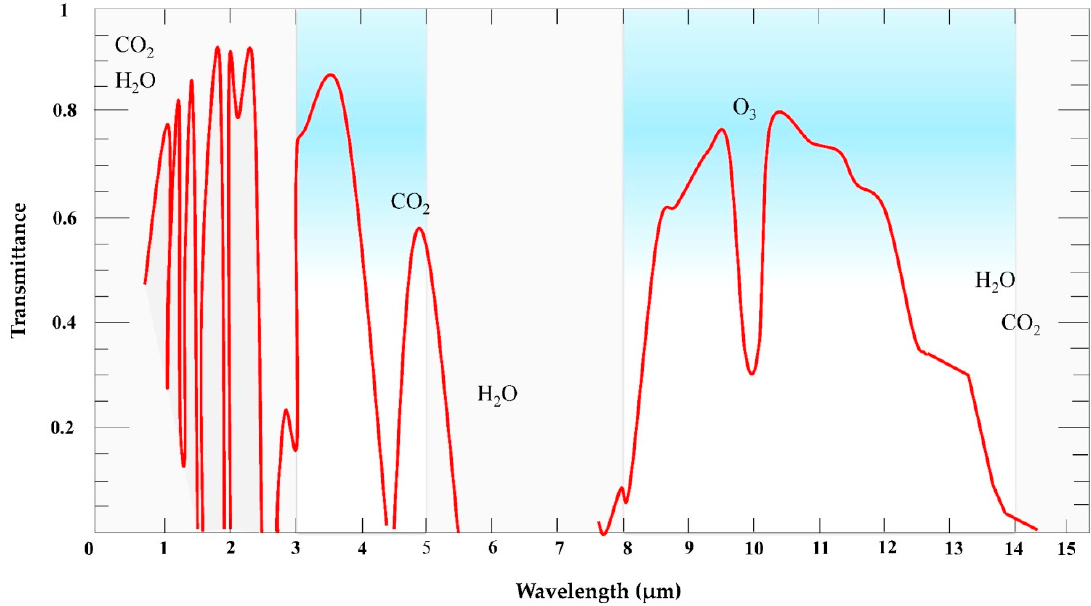
Figure 2. Atmospheric transmittance in the thermal region with typical absorption bands induced by gasses and water (modified from gasses and water (modified from [29]).